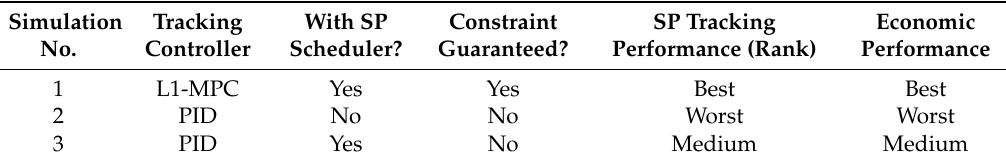
Table 3. The conducted simulation and expected